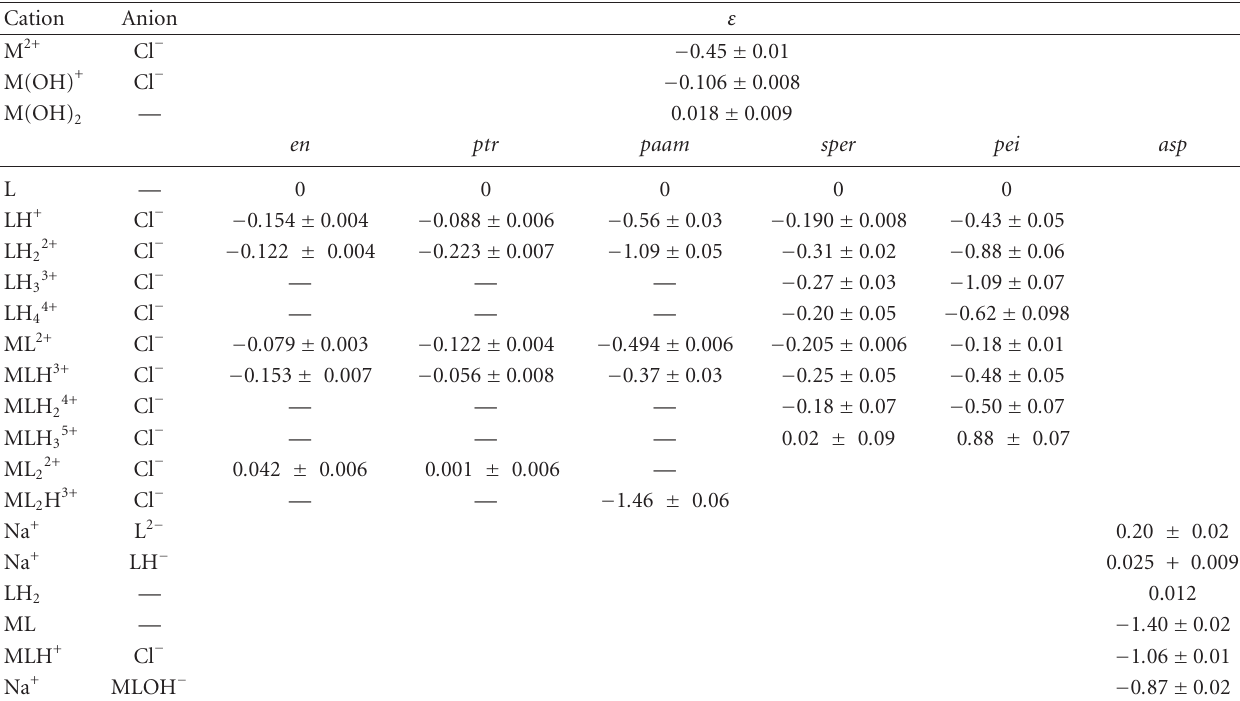
Table 8: Interaction coe ffi cients of Specific ion Interaction Theory (SIT) equations for dmt and ligands species, at t = 25 ◦ C. ± standard deviation.